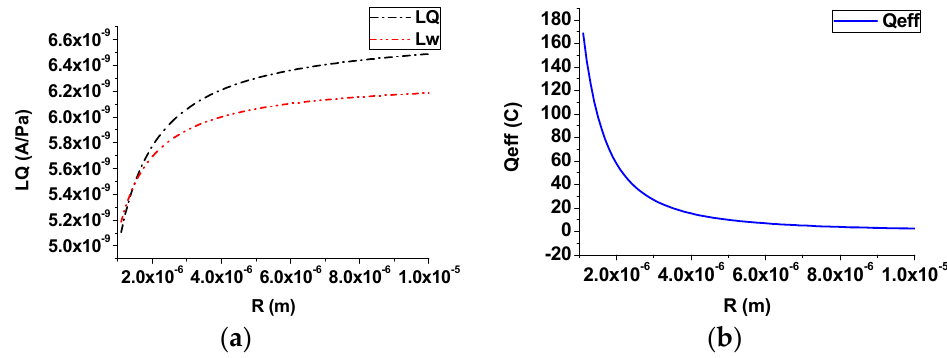
Figure 13. Effect of the pore size (time-harmonic case): ( a ) streaming current coupling coefficient; ( b ) effective net residual charge density.